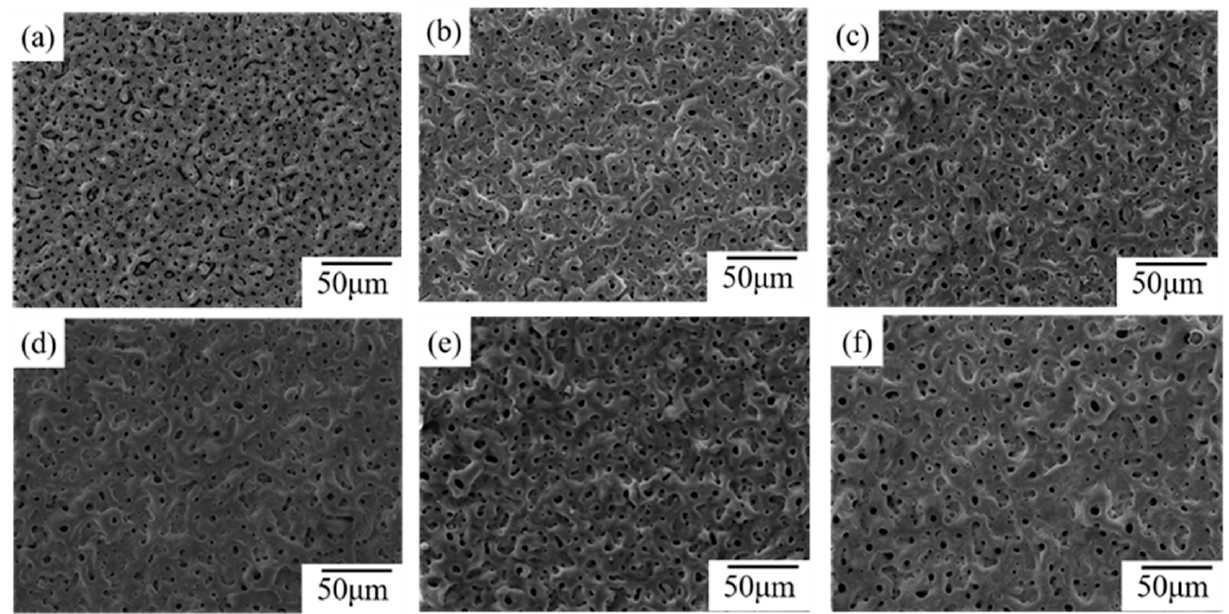
Figure 1. Surface microstructure of MAO coating prepared at different electrolytes with the addition of CuSO 4 of ( a ) 0, ( b ) 2, ( c ) 4, ( d ) 6, ( e ) 8, and ( f ) 10 g/L.